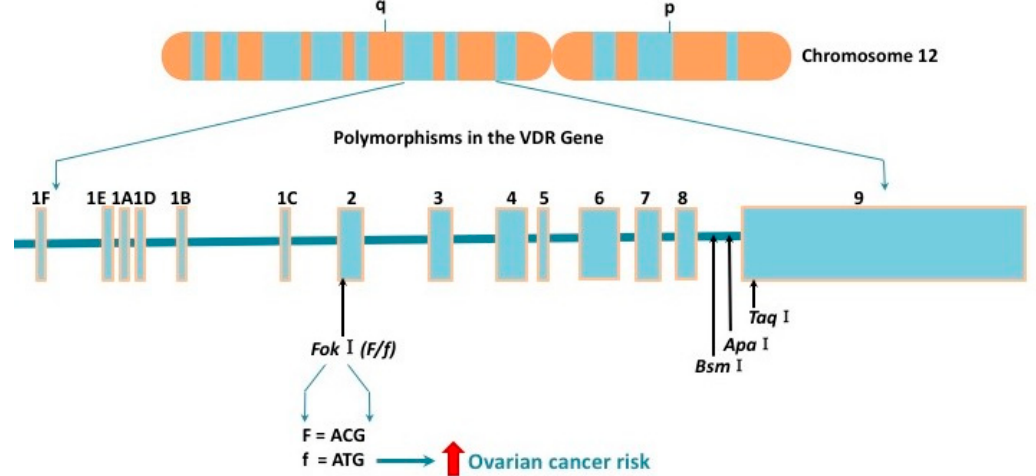
Figure 2. VDR polymorphisms in ovarian cancer: The VDR gene spans 75 kb of DNA and is located on the chromosome 12q12-14, consisting of six 5 ′ noncoding exons (1a–1f) and eight coding exons (2–9). Several VDR polymorphisms have been identified: Fok1, Bsm1, Apa1, and Taq1. The restriction fragment polymorphism of Fok1 alters an ACG codon resulting in an additional start codon and thereby generating a longer VDR protein. The f allele indicates the absence of the restriction site encoding a 427–amino acid protein; the F allele shows the presence of the restriction site encoding a 424–amino acid protein. However, the longer version of the VDR protein exerts less transcriptional activity. Carrying the ff or Ff genotypes increase the risk of ovarian cancer.